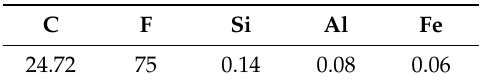
Table 1. Chemical composition (in %) of the fluoropolymer coatings.